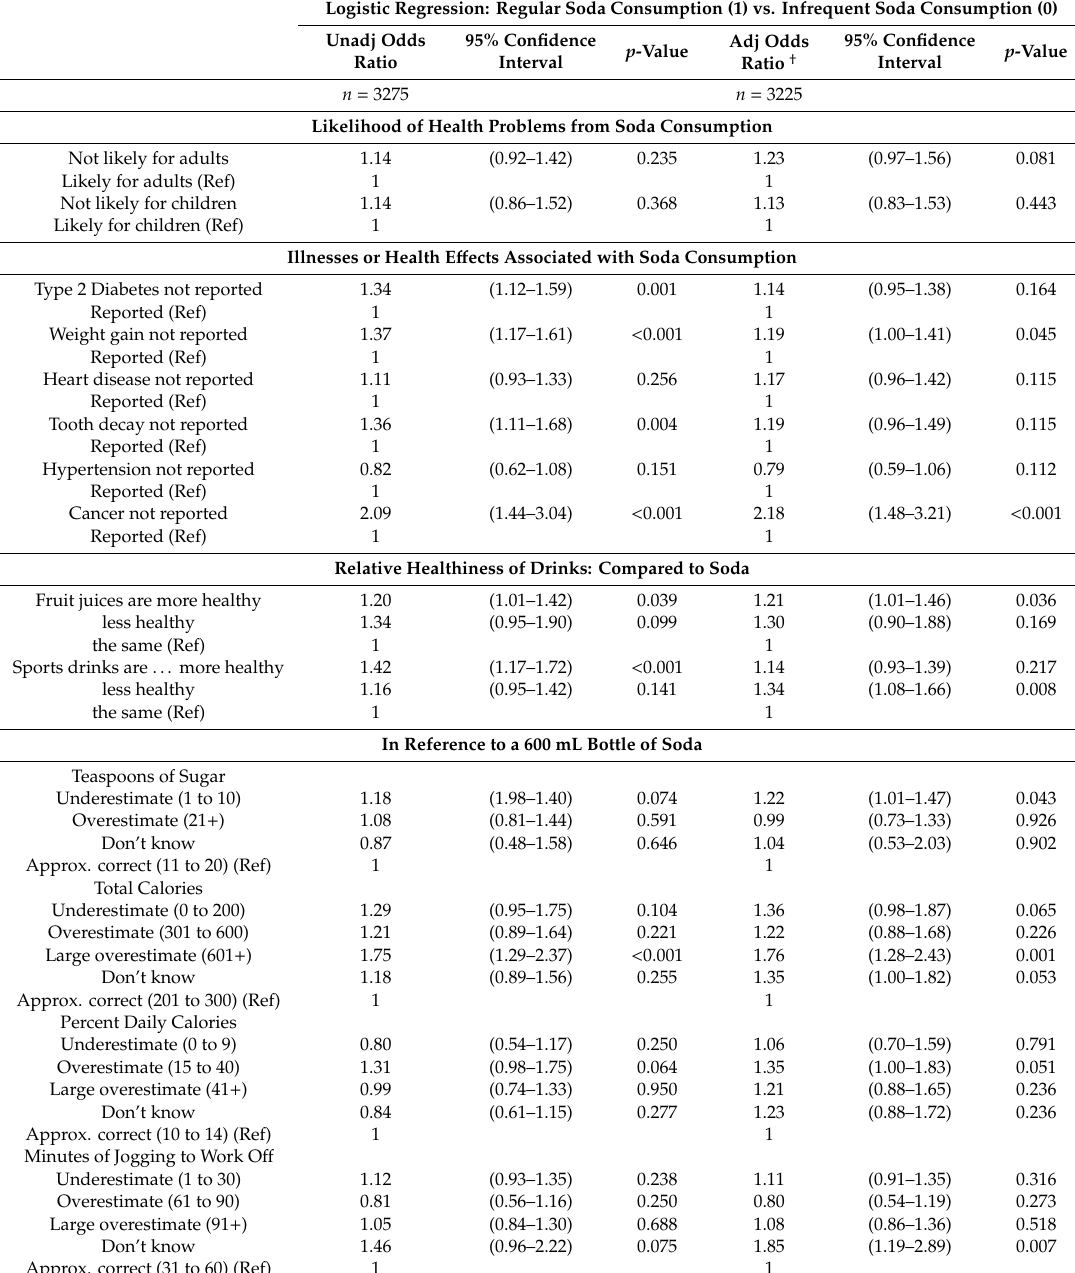
Table 2. Logistic regression predicting soda consumption based on soda-related knowledge and